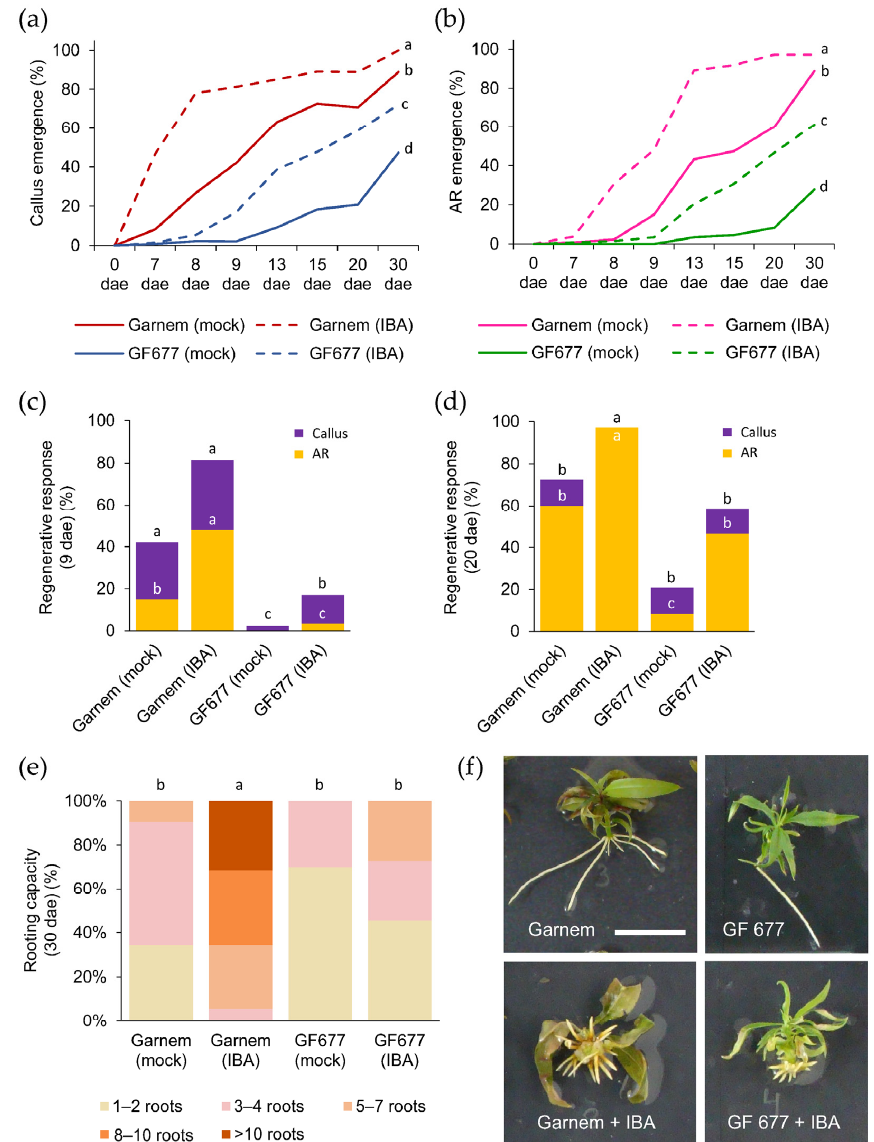
Figure 3. Rooting performance of Garnem and GF 677 microcuttings grown in vitro. ( a , b ) Appear- ance of ( a ) callus and ( b ) ARs over time in microcuttings treated with and without auxin (0.9 mg/L IBA). Letters indicate significant differences ( p -value < 0.05) at 30 days after excision (dae). ( c , d ) Regenerative response estimated by the percentage of cuttings with callus and ARs at ( c ) 9 days after excision (dae) and ( d ) 20 dae. The number of samples varies from 36 to 100. Letters indicate significant differences ( p -value < 0.05; Chi-square) between genotypes in callus regenerative re- sponse, and white letters indicate significant differences ( p -value < 0.05; Chi-square) between geno- types in AR regenerative response. ( e ) Rooting capacity measured at 30 dae. Letters indicate signif- icant differences ( p -value < 0.01) for the average number of ARs. ( f ) Representative images of Gar- nem and GF 677 microcuttings at the end of the experiment. Scale bar: 2.5 cm.